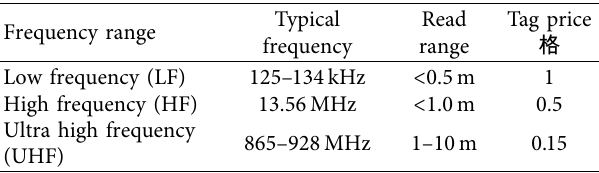
Table 1: Operating frequency and reading range of passive UHF RFID. Frequency